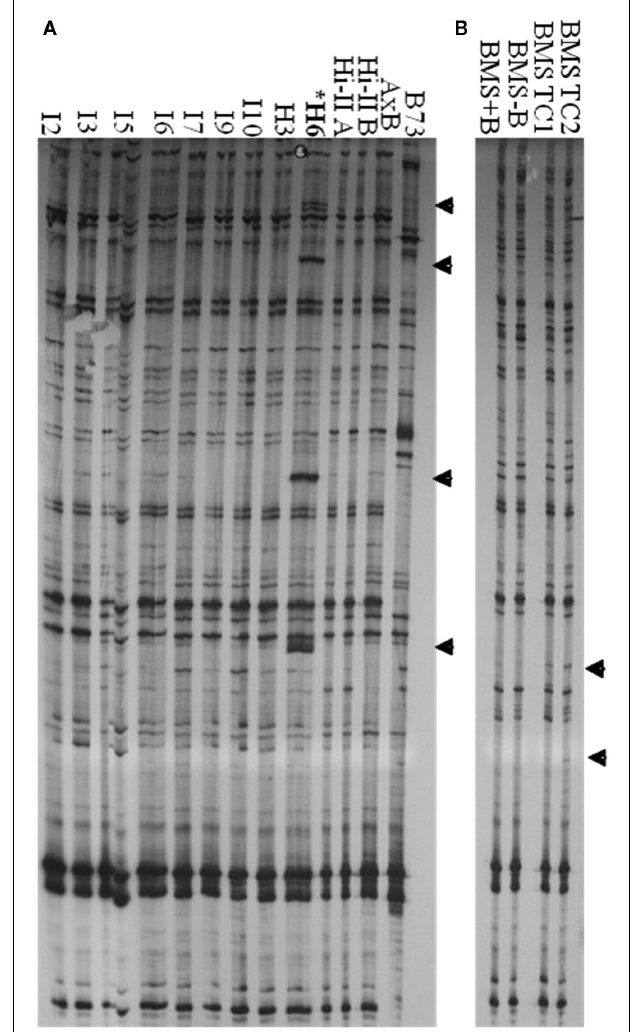
FIGURE 7 | 3 (cid:2) TCUP transposon display performed on genomic DNA from Hi-IIA × B callus lines, B73 seedlings, BMS seedlings, and BMS callus. (A) Independent Hi-II A × B callus lines compared to Hi-II A × B and B73 seedlings. DNA from biological replicates was used to confirm the consistency of the transposon display results.Tissue culture lines are represented by I or H followed by the biological replicated number. Samples within each tissue line were: I2-1 and I2-5, I3-1 and I3-5, I5-2 and I5-6, I6-2, I6-3, and I6-4, I7-1 and I7-2, I9-2 and I9-3, I10-2 and I10-3, H3-3 and H3-6, H6-2, H6-3, and H6-4. (B) BMS seedling tissue from lines with and without B chromosomes compared to BMS callus lines. Novel bands are marked with an arrow and line H6 is marked with an